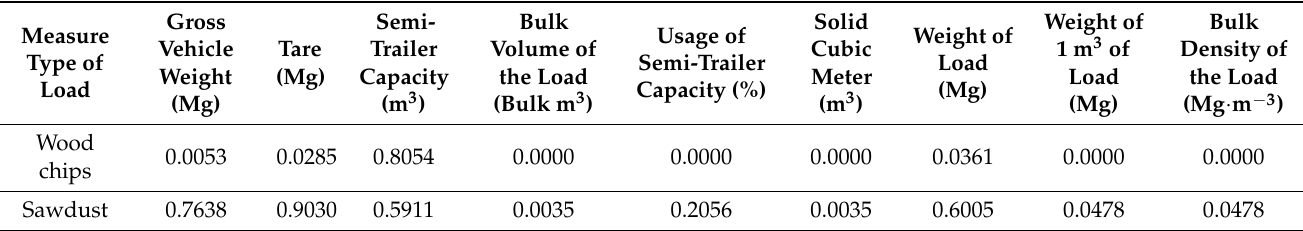
Table 2. The results of the assessment of the significance of differences of selected features depending on the load.